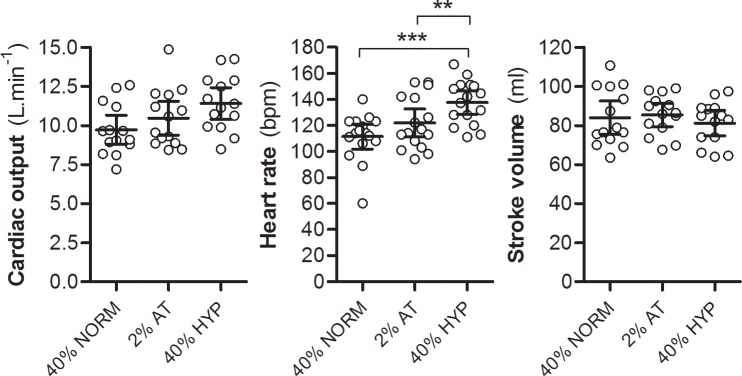
Cardiac output, heart rate and stroke volume.The increase in cardiac output during exercise in hypoxia (40%peak+HYP) was entirely attributed to an increase in heart rate, while stroke volume was not statistically different between exercise conditions, suggesting a purely autonomic and non-mechanical difference in hypoxia. IAT = individual anaerobic threshold; *: P < 0.05; **: P < 0.01; ***: P < 0.001.